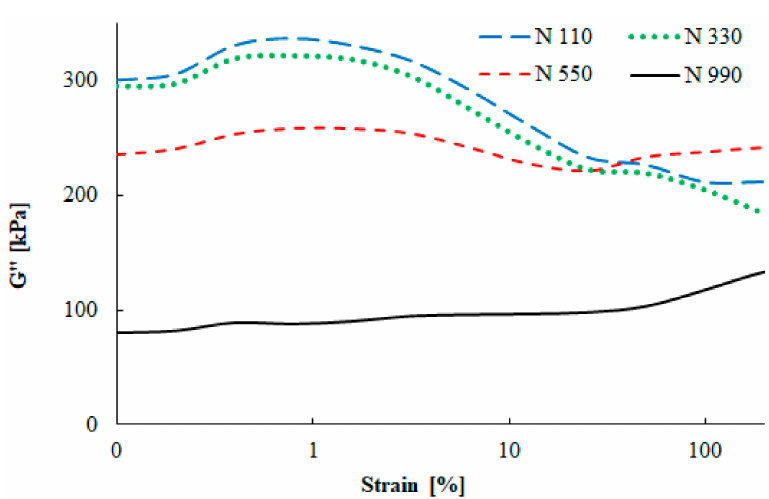
Figure 9. Strain amplitude dependence of the shear storage modulus.